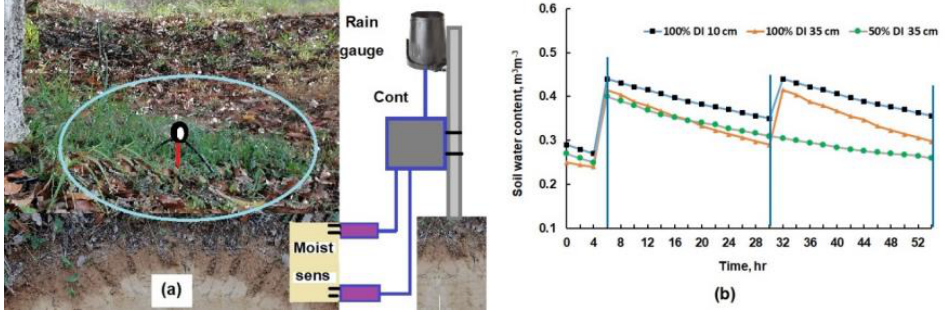
Figure 6. Water moisture measurement ( a ) in the soil with two sensors, and ( b ) graphs with 100% DI and 75% RDI (blue lines denote irrigation timing).